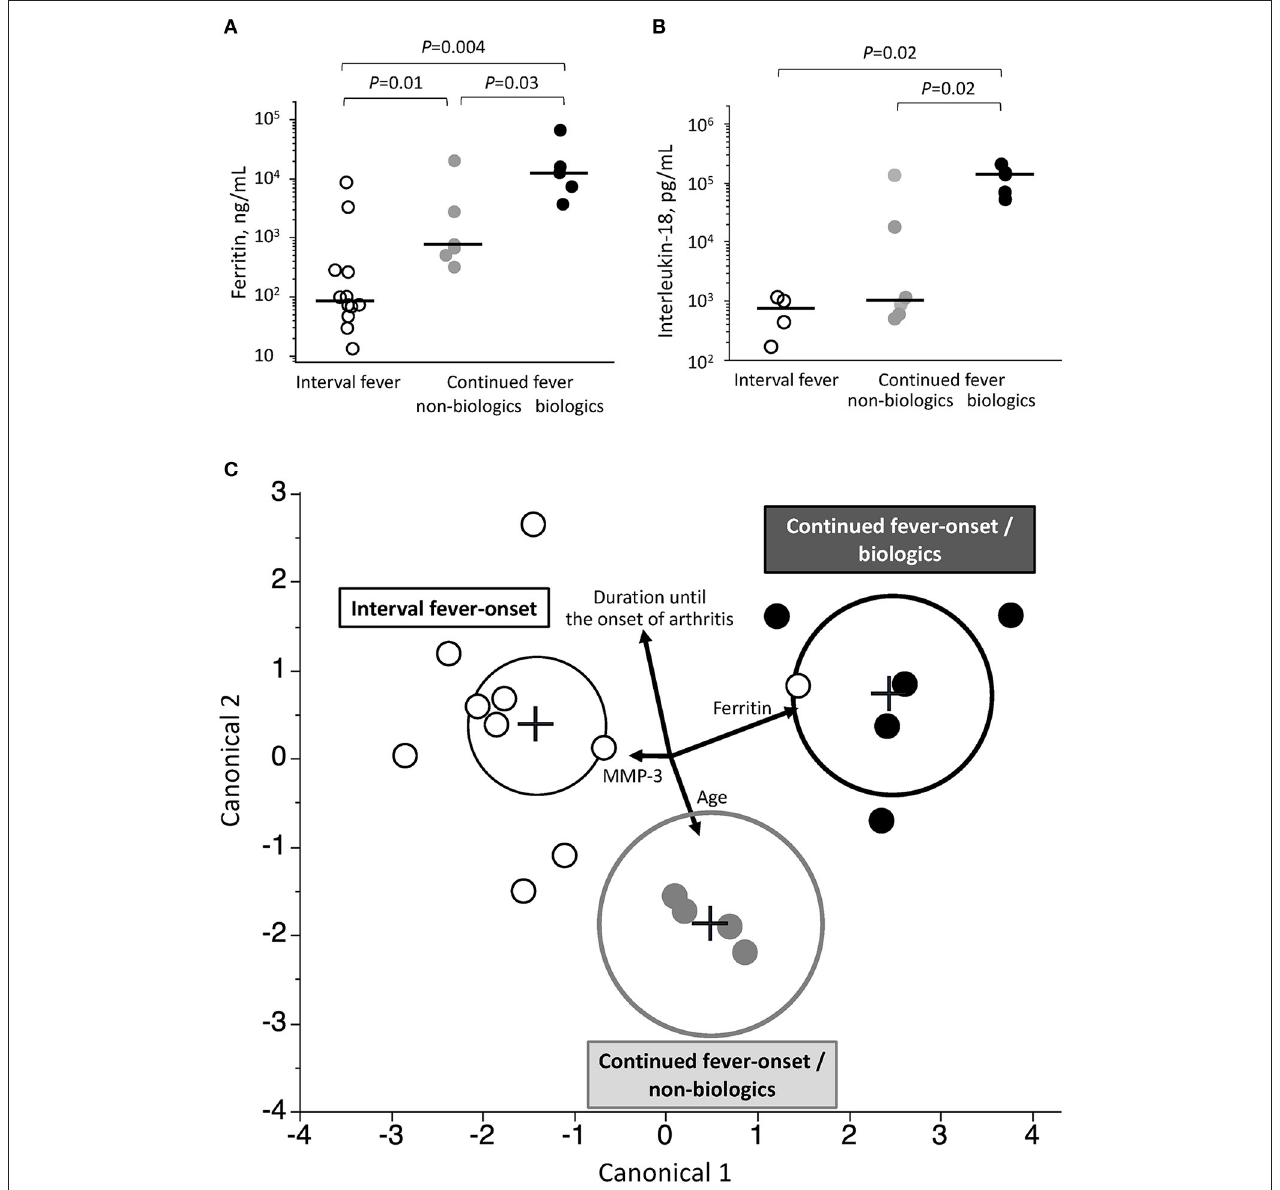
FIGURE 3 | Associated clinical variables among the three groups of patients with KD-related arthritis. (A,B) Comparison of serum levels of ferritin (A) and interleukin-18 (B) at the onset of arthritis among patients in the continued fever-onset/biologic, continued fever-onset/non-biologic, and interval fever-onset groups. Black bars represent the median values. (C) A prediction model to predict the three types of the KD-related arthritis based on a canonical discriminant analysis. Each plot is determined using the combination of 4 clinical covariates at the onset of arthritis. Vectors indicate the direction and magnitude of each element. Black, gray, and white plots represent patients in the continued fever-onset/biologic, continued fever-onset/non-biologic, and interval fever-onset groups, respectively. The black, gray, and dotted circles in (B) denote the 95% confidence ellipse in the continued fever/biologic, continued fever-onset/non-biologic, and interval fever-onset types, respectively.